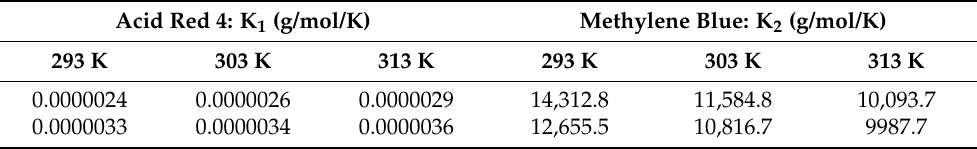
Table 4. Intraparticle model parameters for the adsorption of AR4 and MB on AC.